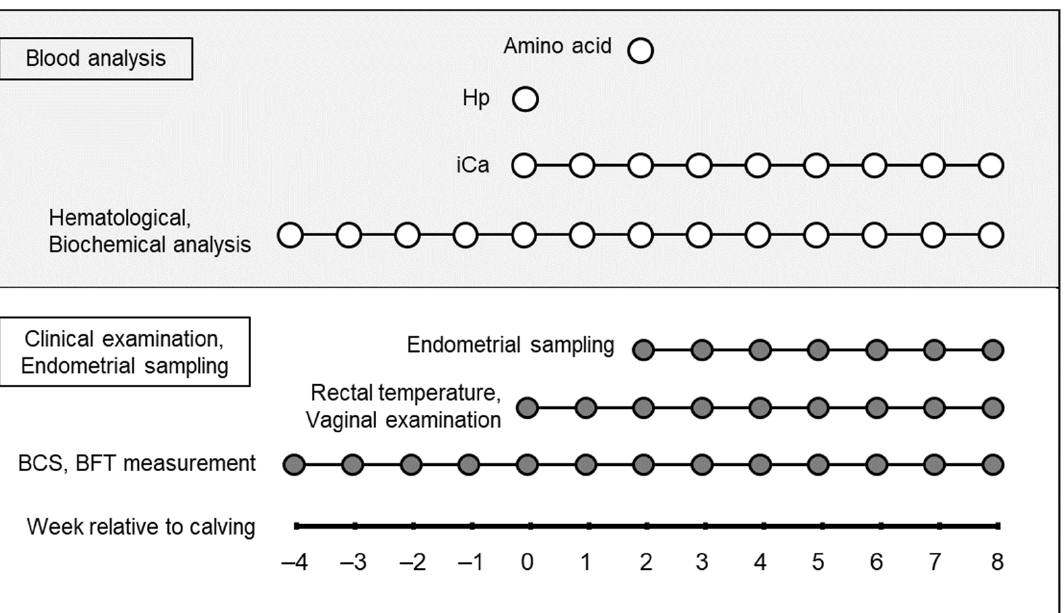
Figure 1. Schematic diagram of the experimented model. The week of calving is defined as 0 wk. Hp = Haptoglobin; iCa = ionized calcium; BFT = backfat thickness.